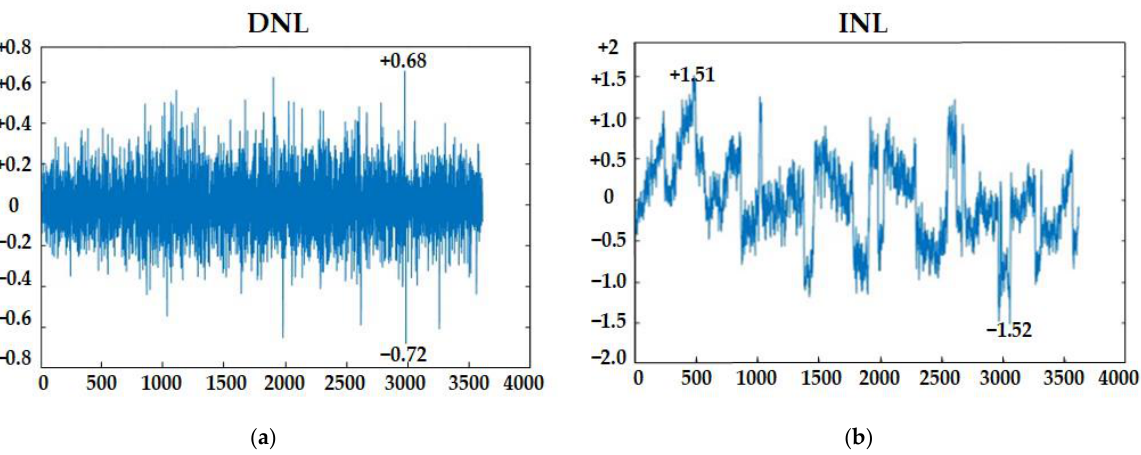
Figure 15. 12-Bit 1 GS/s Pipelined ADC micrograph.